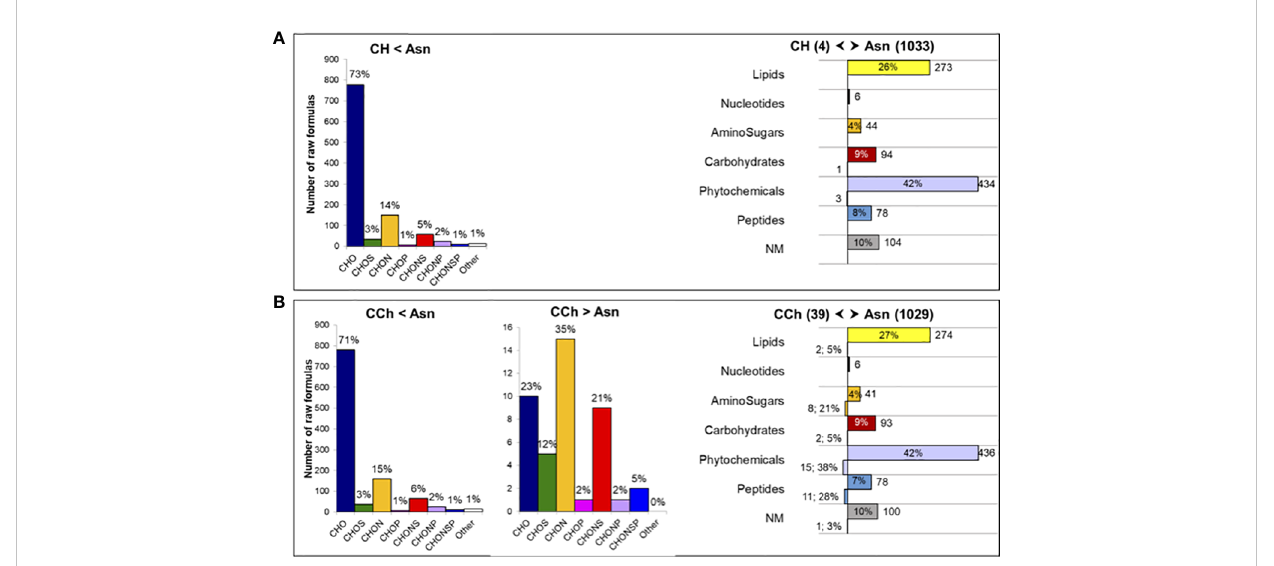
FIGURE 3 Comparison of the metabolome of the wood interaction area of vines treated or not by sodium arsenite. Comparison of the signi fi cantly regulated m/z of (A) healthy (CH) and Asn-treated (Asn) vines and (B) diseased (CCh) and Asn-treated (Asn) vines. Chemical classes of the corresponding raw formulas containing C, H, O, N, S, and P atoms (determined from 1,057 and 1,087 m/z ), with the indication of the percentage of distribution in each class (left panels). Functional categorization (right panels) of the annotated compounds differently regulated in samples (1,037 and 1,068 compounds), with the indication of the number and percentage of distribution in each biochemical category. Functional categories were predicted from raw formulas according to Rivas-Ubach et al. (2018). NM,